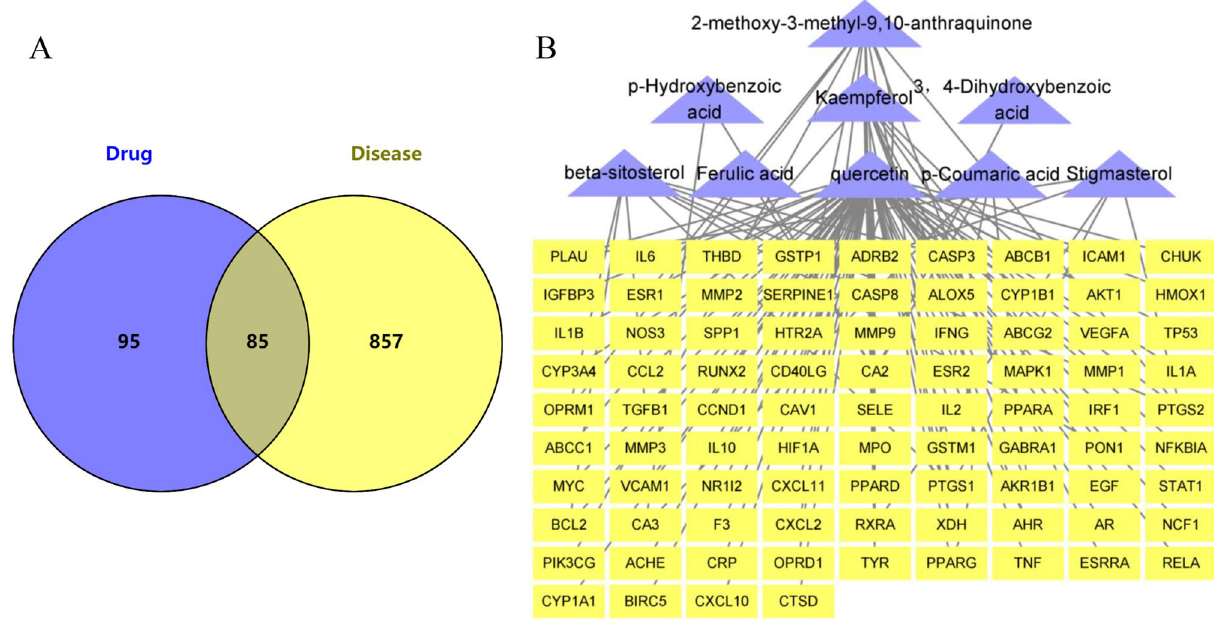
Figure 2. Construction of the components-targets-RA Network. ( A ) Venn diagram of active ingredients of HDW and RA targets. ( B ) Active ingredients-targets-RA network. Purple triangles represent 9 components of HDW and yellow rectangles represent common